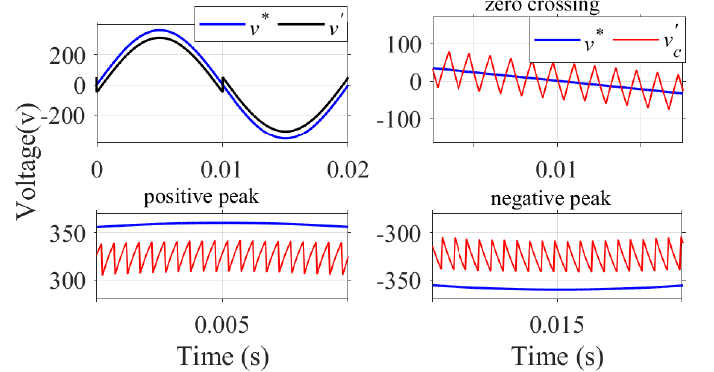
Figure 8. THD vs. Fixed offset.